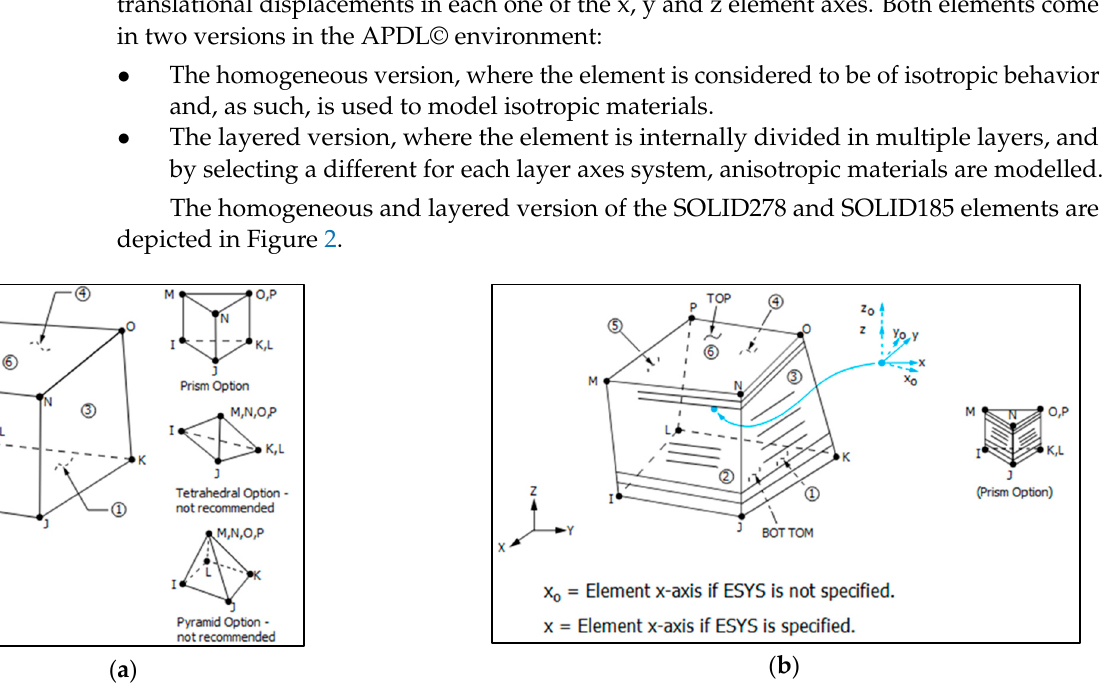
Figure 2. Graphical representation of the homogeneous ( a ) and the layered ( b ) version of SOLID278 and SOLID185 elements of the APDL© software [31]. and SOLID185 elements of the APDL© software